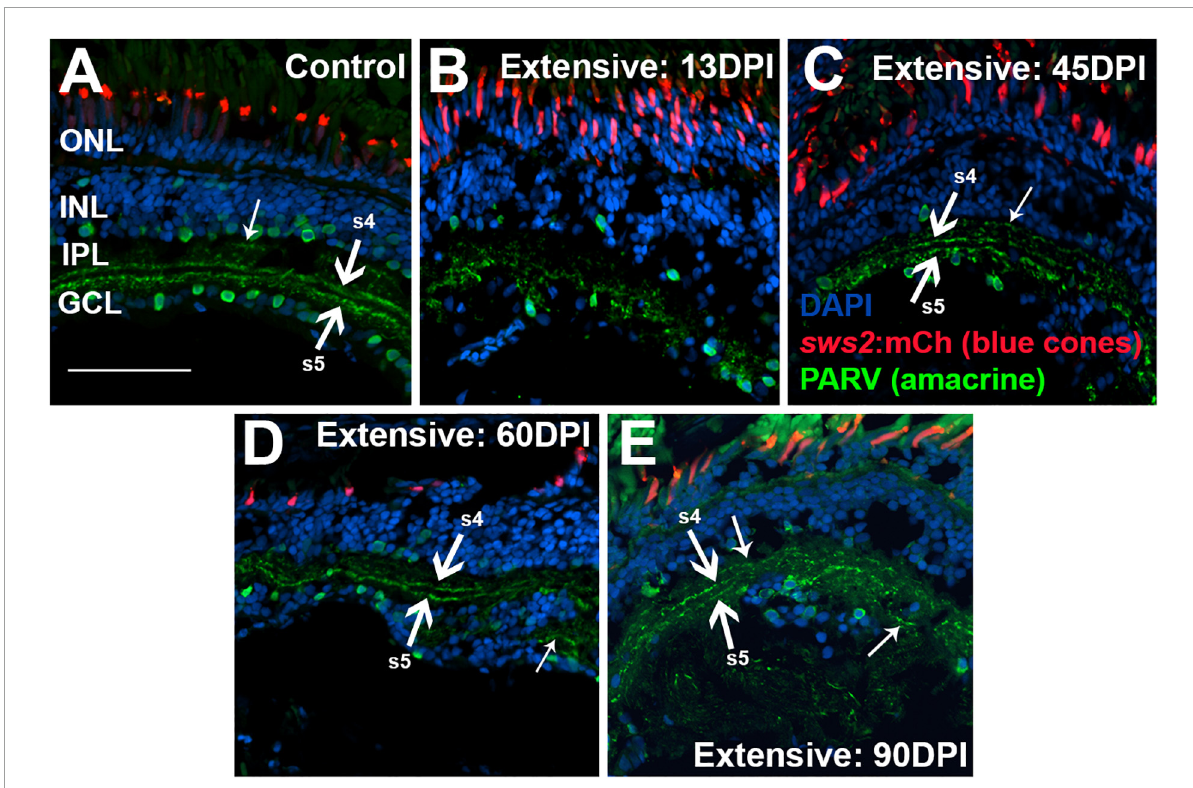
FIGURE8 Time-course of restoration of PARV + amacrine cells and their synaptic processes following extensive lesion. Tissues were processed for indirect immunofluorescence and imaging after ERG recordings. (A) Control retina displaying characteristic pattern of PARV + amacrine cells within the inner nuclear layer (INL) and ganglion cell layer (GCL), and stripes of processes occupying inner plexiform layer (IPL) sublaminae s4 and s5 (thick arrows), which receive input from ON-bipolar neurons. Occasional stripes of PARV + processes were also observed within OFF sublaminae (thinner arrow). (B–E) Regenerating retinas at 13 (B) , 45 (C) , 60 (D) , and 90 days post-injury (DPI) (E) . PARV + sublaminae are not recognizable at 13 DPI, but can be observed at 45, 60, and 90 DPI (arrows), although these patterns are not consistent across the retina. Thick arrows again depict likely sublaminae s4 and s5, while the thinner arrows point to PARV + processes within OFF sublaminae (as in C ), or disorganized processes with atypical lamination patterns (as in D ). ONL, outer nuclear layer; scale bar (in A, applies to all) = 50 µ